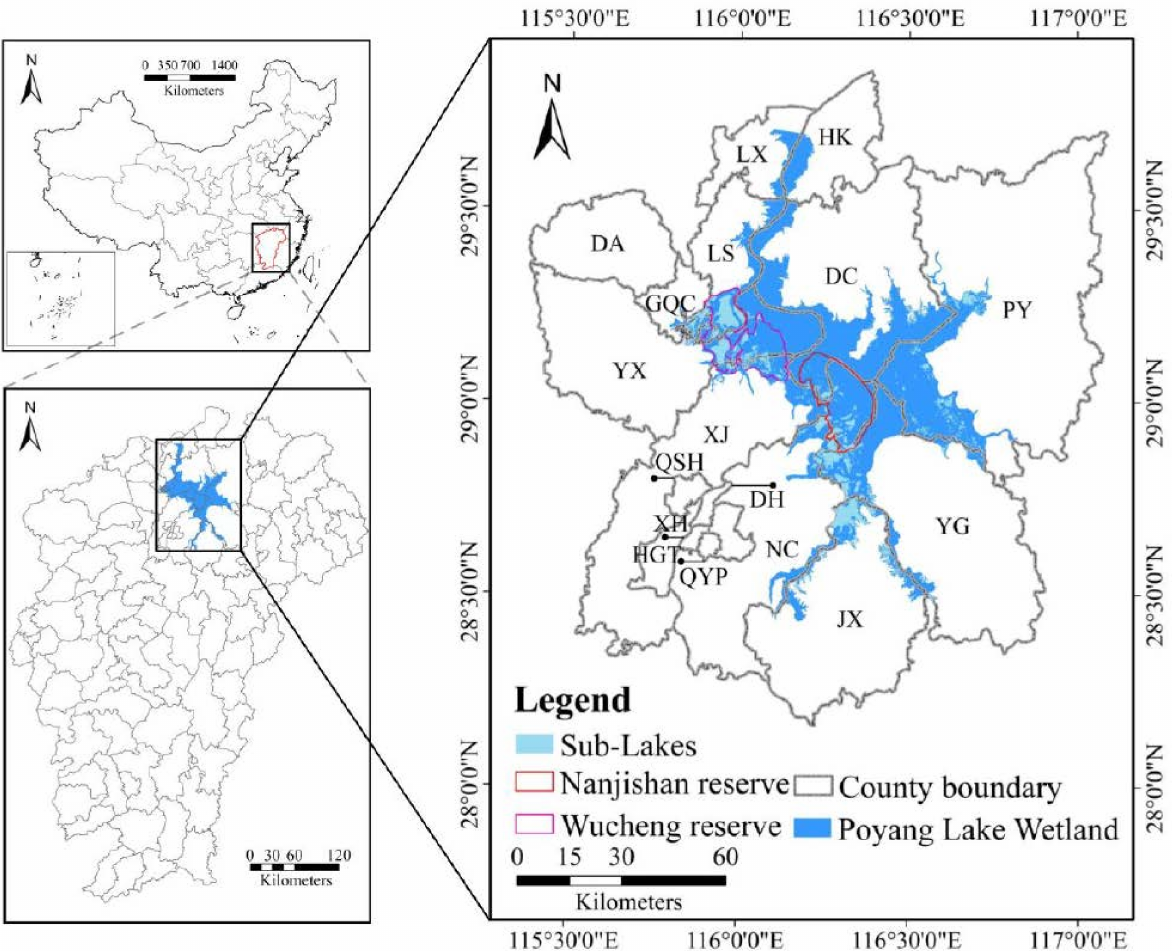
Figure 1. Locations of the Poyang Lake wetland, the sub-lakes and the national nature reserves (names of the county around Poyang Lake are abbreviated as follows: DA, Dean; DC, Duchang; DH, Donghu; GQC, Gongqingcheng; HGT, Honggutan; HK, Hukou; JX, Jinxian; LS, Lushan; LX, Lianxi; NC, Nanchang; PY, Poyang; QSH, Qinshanhu; QYP, Qinyunpu; XH, Xihu; XJ, Xinjian; YG, Yugan; and YX,